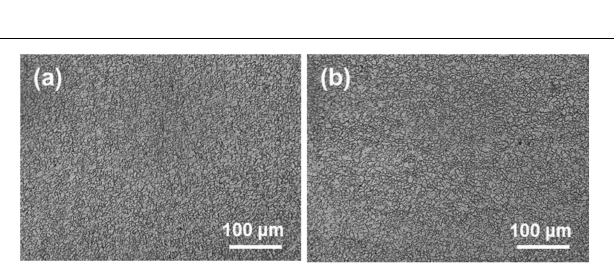
FIGURE 8 | OM of SZ-center in FSPed AZ31/ZrO 2 composites: (a) Z1-3P specimen and (b) Z2-3P specimen.